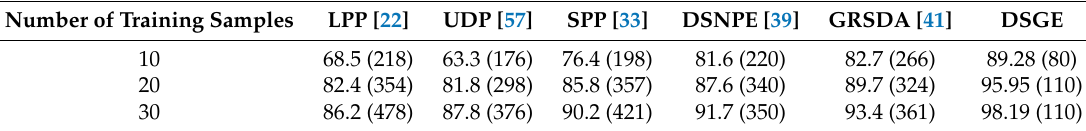
Experiment 2: For further demonstrating the e ff ectiveness of DSGE against occlusion on the Extended Yale B database, we randomly selected 14 images of each individual and added noise occlusion block with black and white dots with random distribution. The location of noise occlusion block was random and the ratio of size between noise occlusion block and original image was also random where the ratio parameter ranged from 0.05 to 0.15. Some occlusion samples of one person are depicted in Figure 6. In this section, we did the following experiments by two cases. (1) We randomly selected 32 images per person which included 14 images with noise occlusion block, and the remaining images for testing. (2) We randomly selected 32 images per person which contained seven images with noise occlusion block, and the remaining images for testing. All experiments in